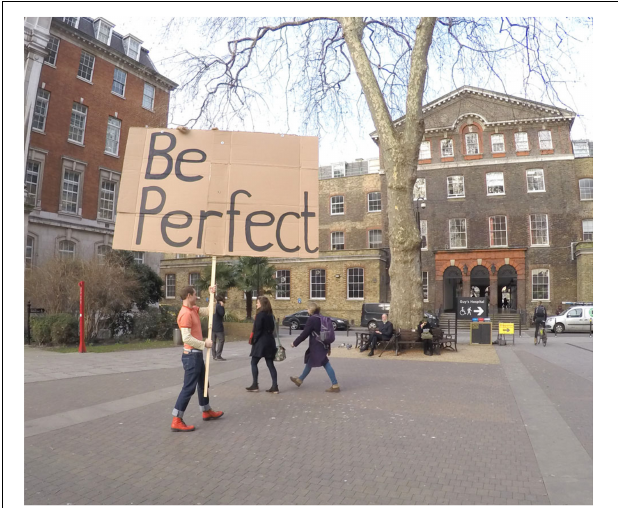
FIGURE 3 | Schrag holding “be perfect” placard from the Secret Society of Imperfect Nurses. Anthony Schrag.